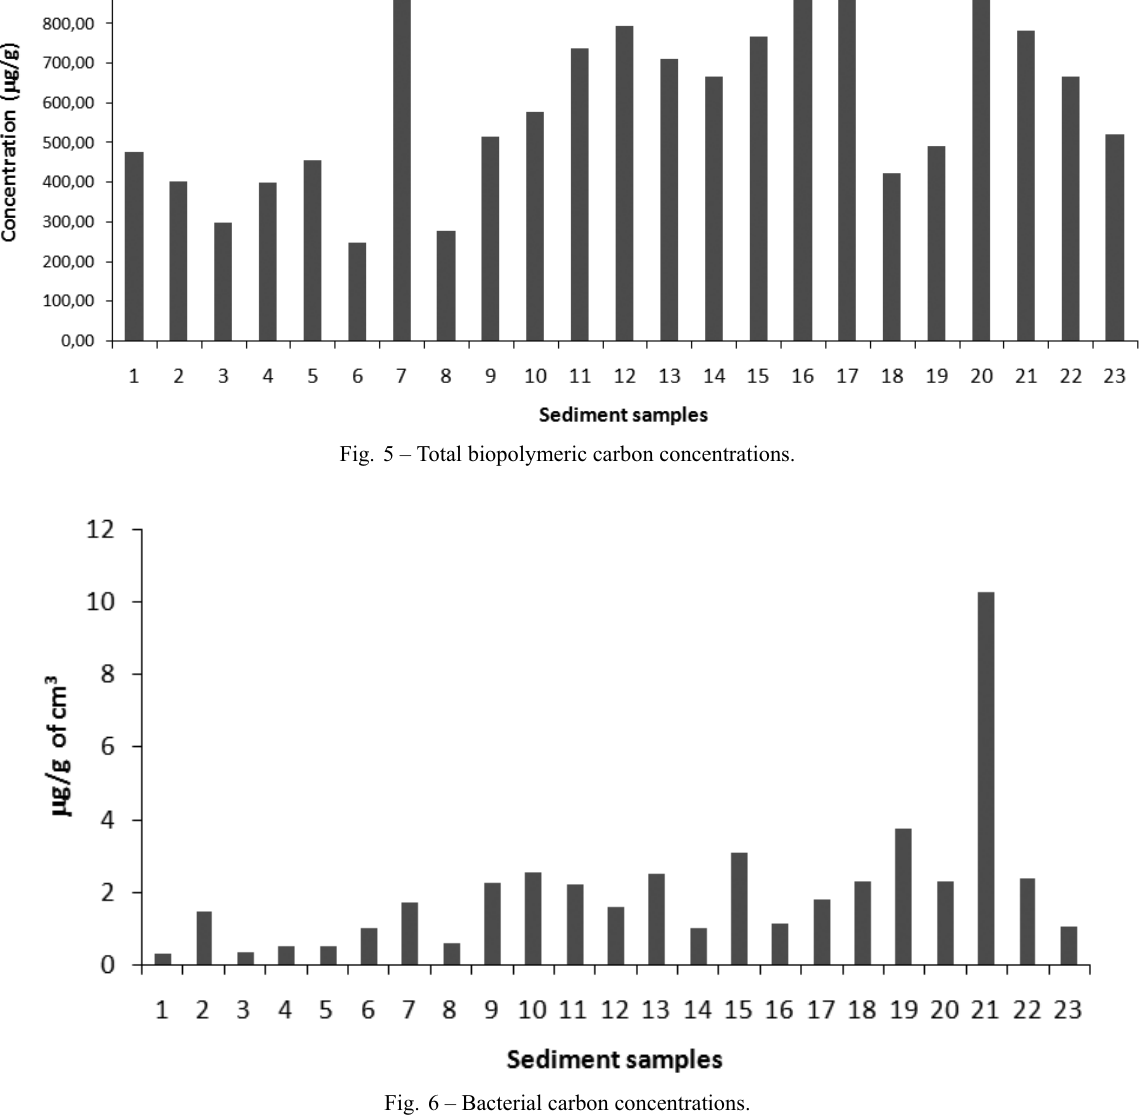
Fig. 6 – Bacterial carbon